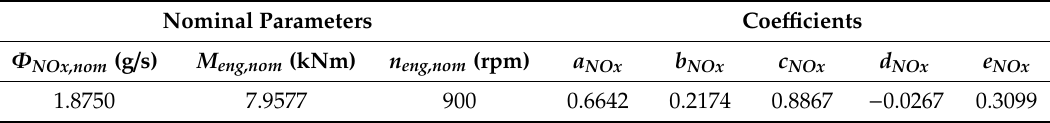
Table A4. Coe ffi cients of NOx emission model of auxiliary engine.